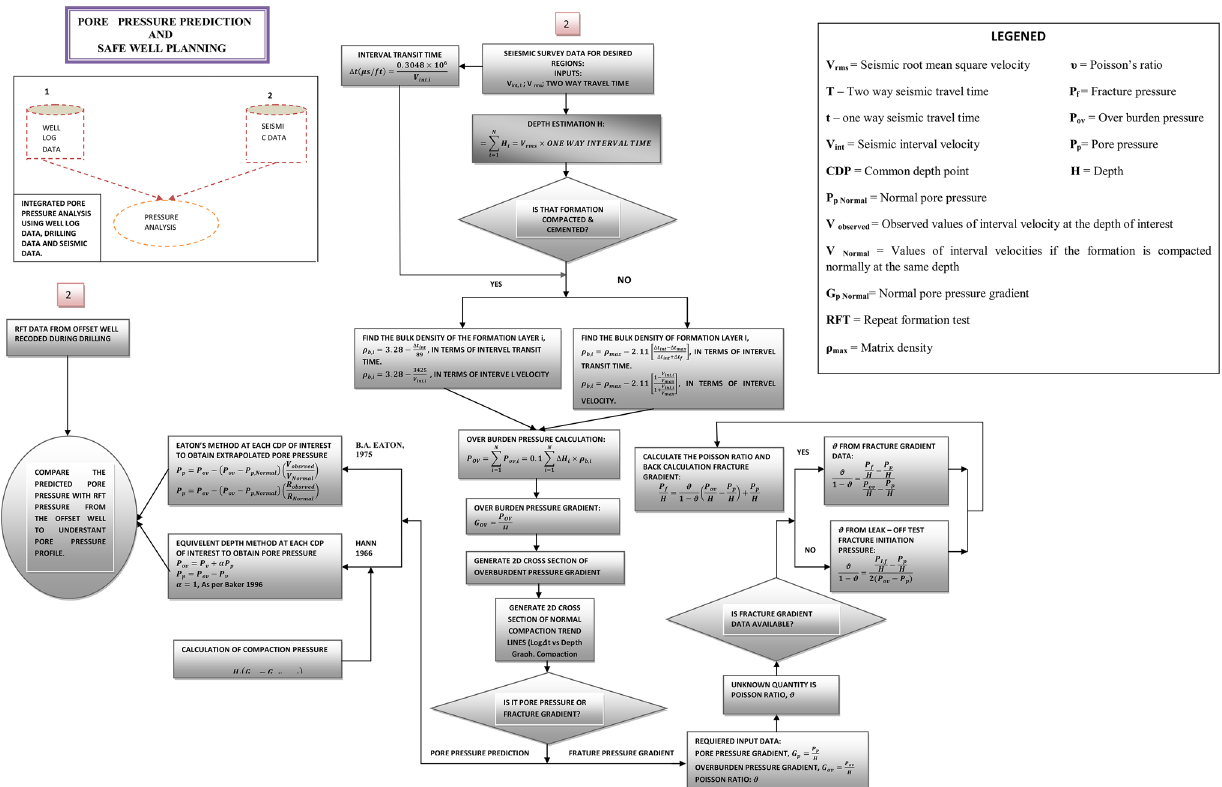
Fig. 5 Flow chart for pore and fracture pressures